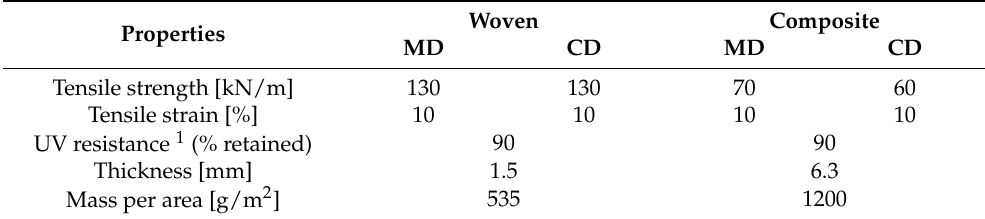
Table 1. Properties of woven and composite-engineered fabrics.